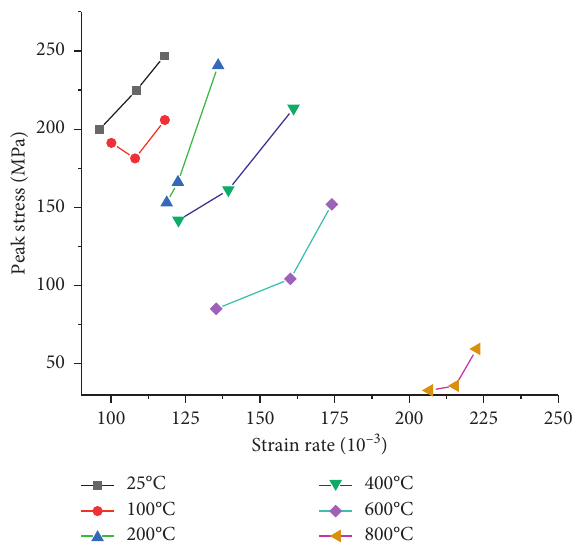
Figure 16: Peak stress-strain rate curves of rock under different impact speeds and different temperatures.